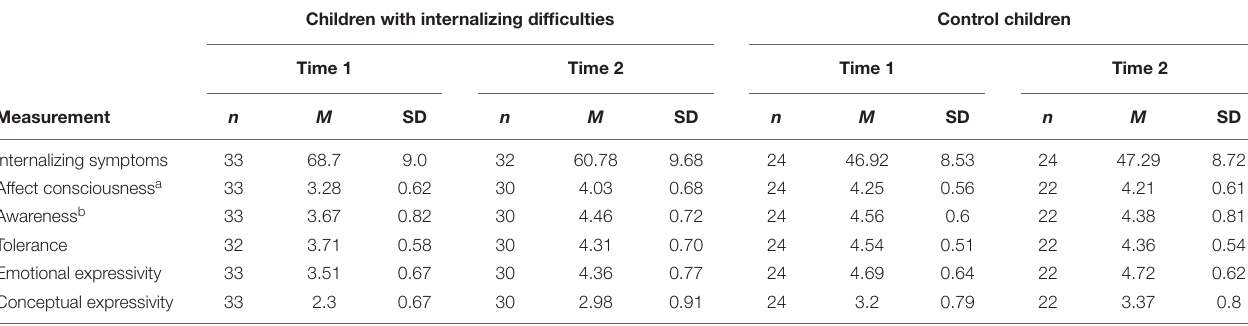
TABLE 1 | Means and standard deviations of internalizing symptoms and affect integration at time 1 and 2. Children with internalizing difficulties Control children